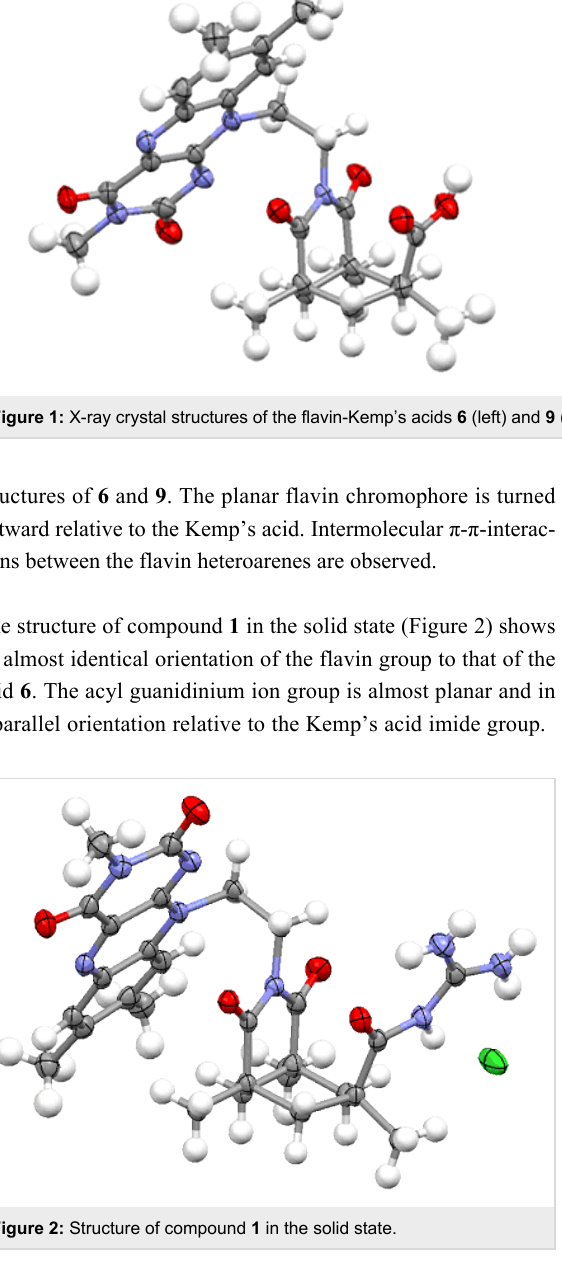
Figure 3: Calculated lowest energy conformation of 1 in the gas phase (AM1, Spartan program